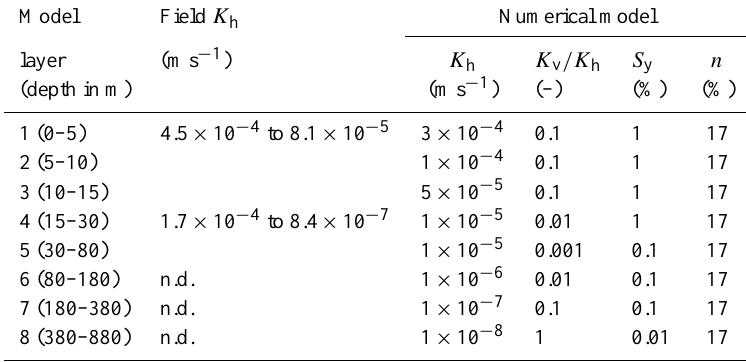
Table 5. Field-based and calibrated hydraulic properties of the FEFLOW numerical model for the Prince Edward Island aquifer